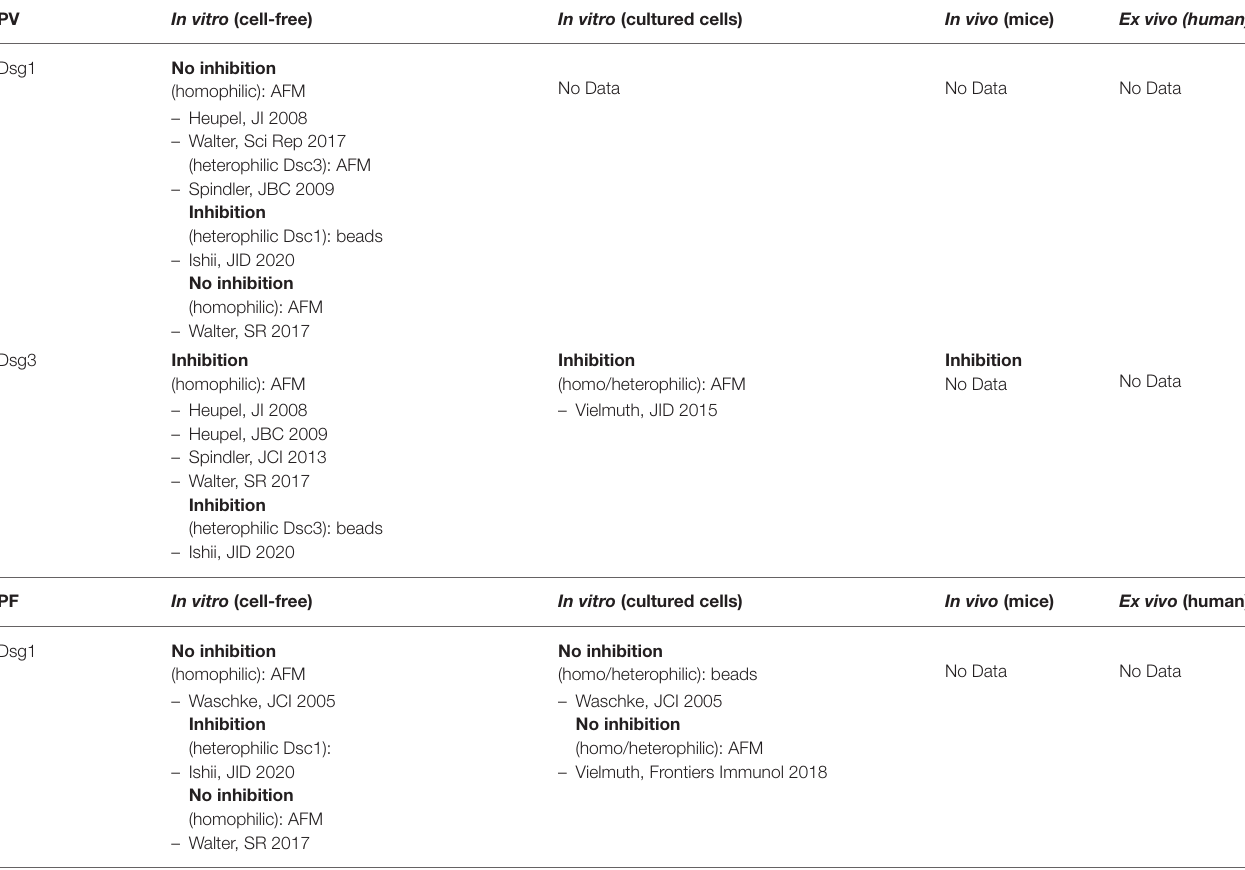
TABLE 1 | Studies on direct inhibition of Dsg1 and Dsg3 interaction in pemphigus. PV In vitro (cell-free) In vitro (cultured cells) In vivo (mice) Ex vivo